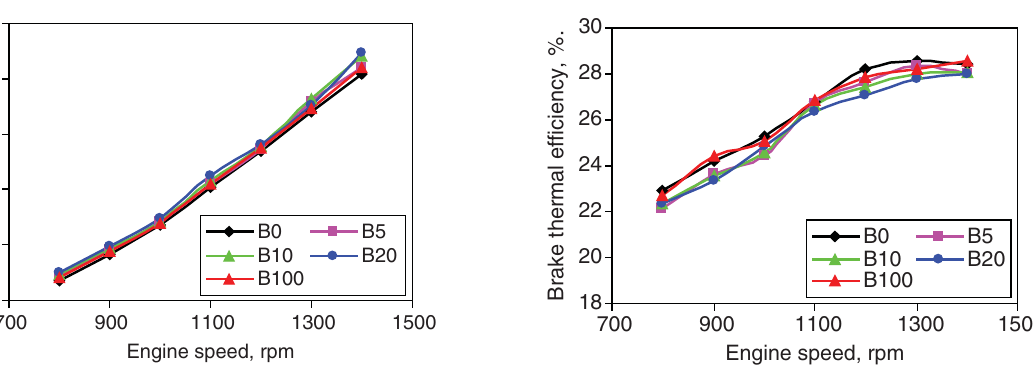
Fig. 8. The effect of tested fuels on the brake thermal efficiency as a function of the